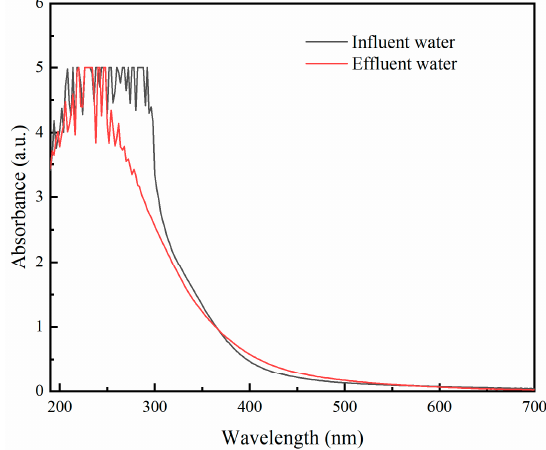
Figure 6. UV spectral analysis of influent and effluent water.